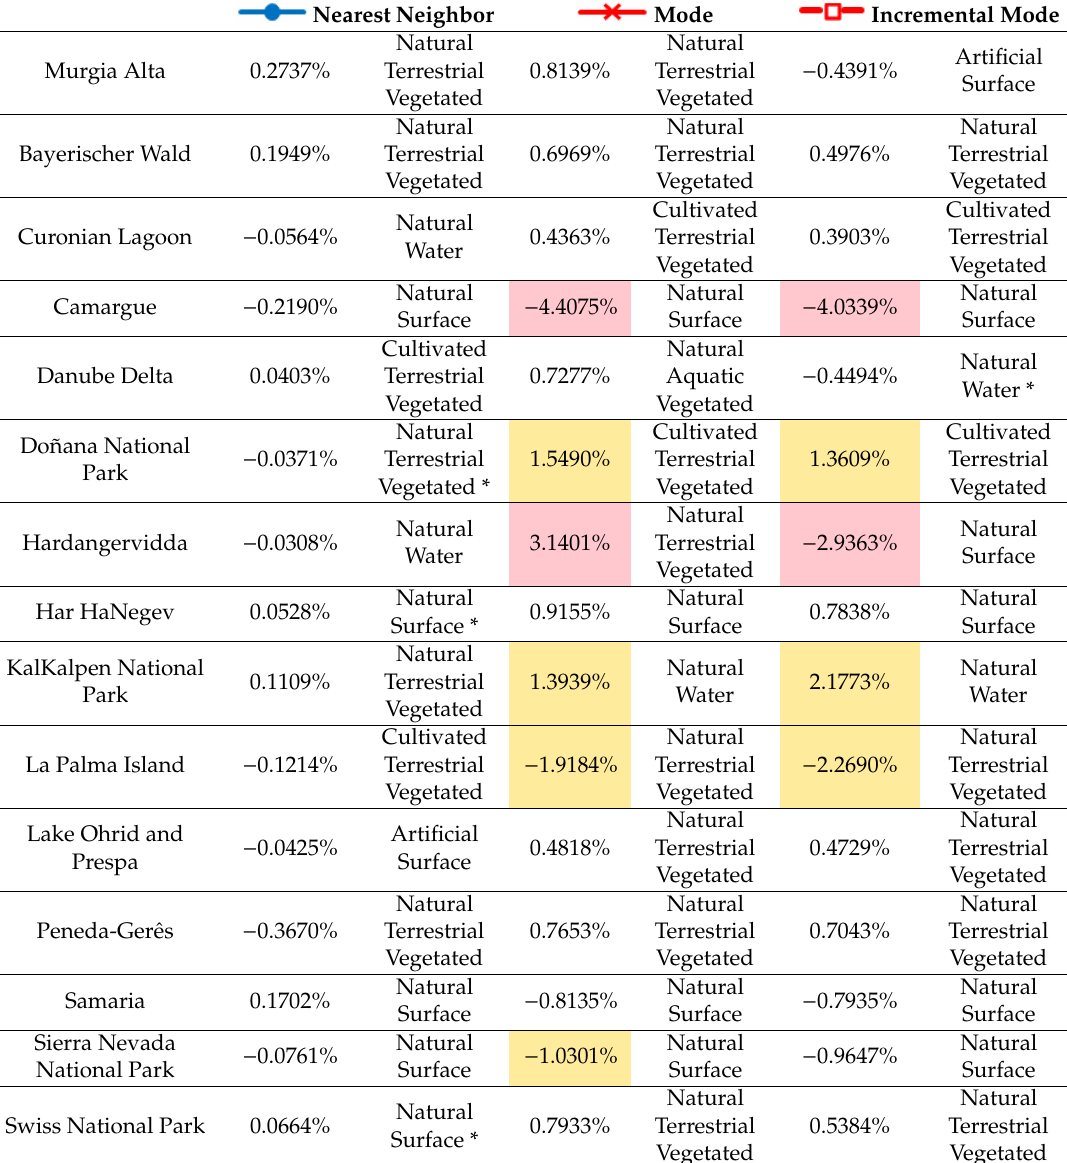
Table 2. Absolute maximum variation for each protected area for all categories and resolutions. Variations are shown in percentage points. The yellow background highlights scenarios with an absolute variation between 1 and 2.5 percentage points, and the red background highlights scenarios with a variation higher than